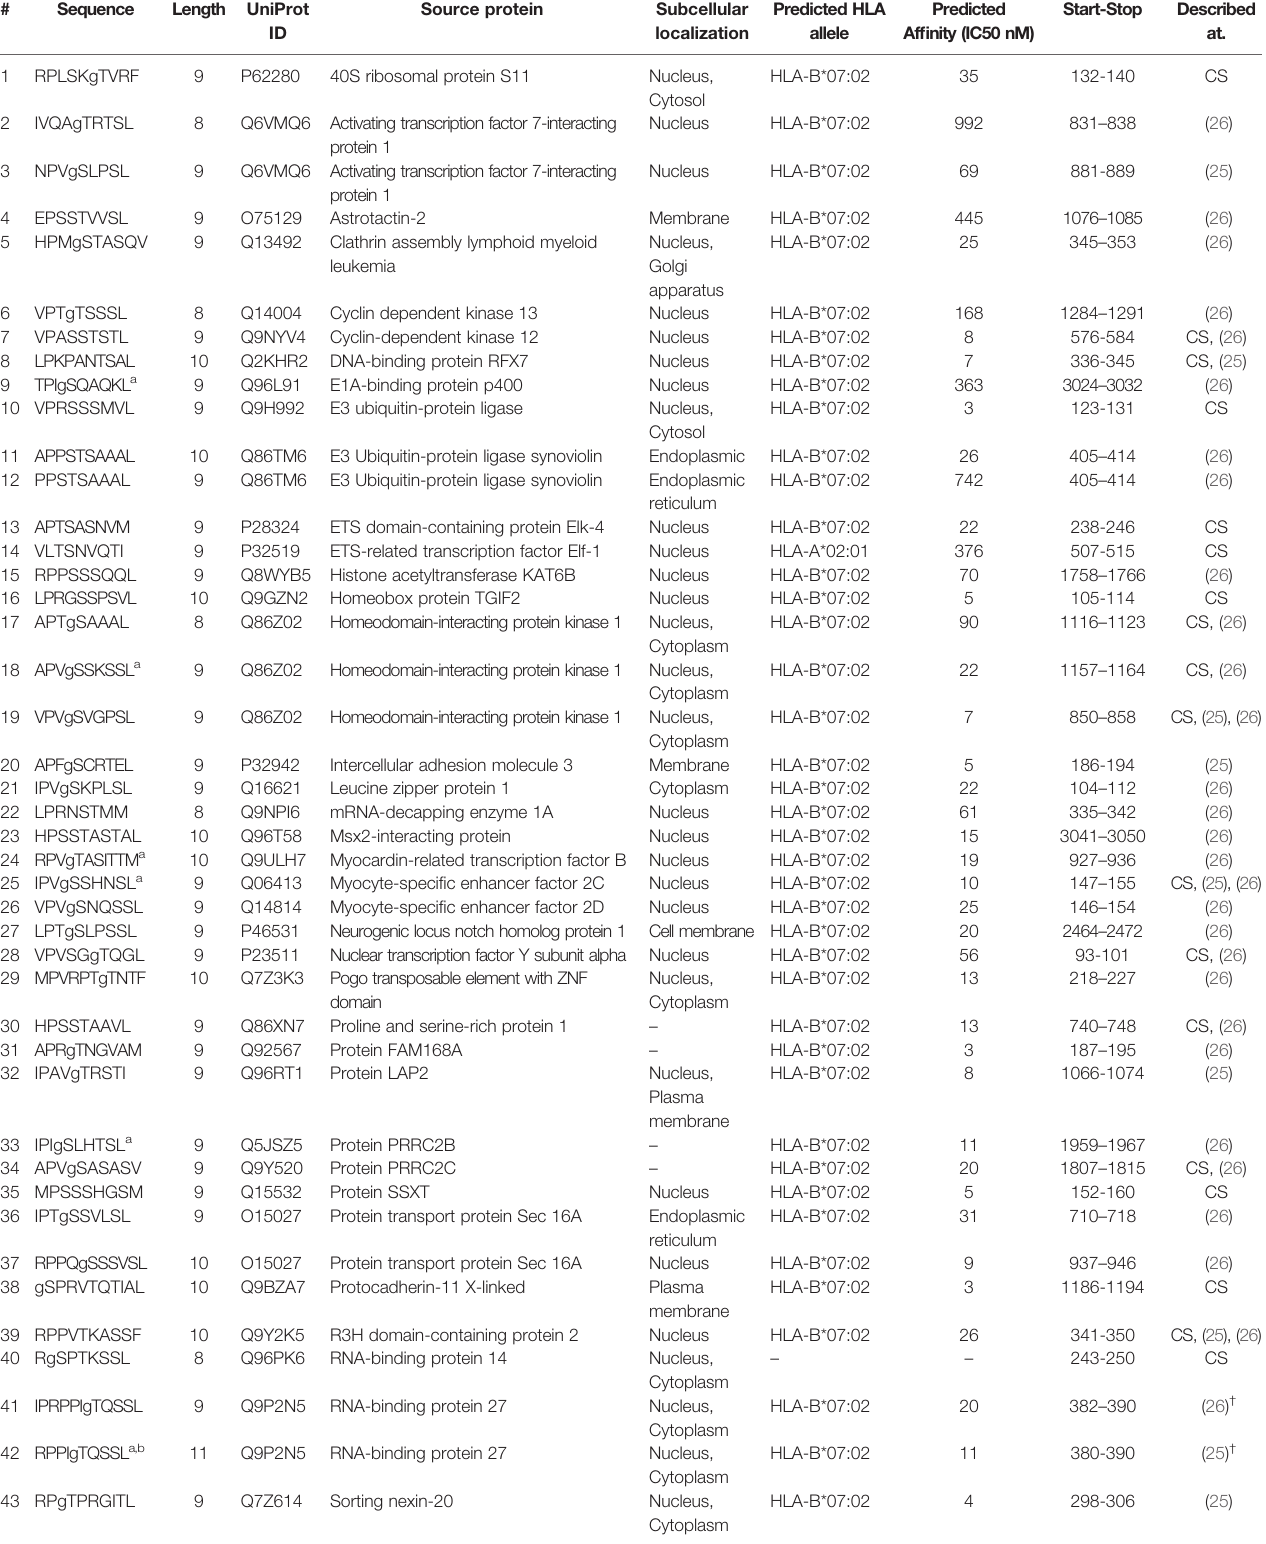
TABLE 1 | Compilation of O-GlcNAcylated HLA class I peptides identi fi ed in the current study by Marino et al. and Malaker et